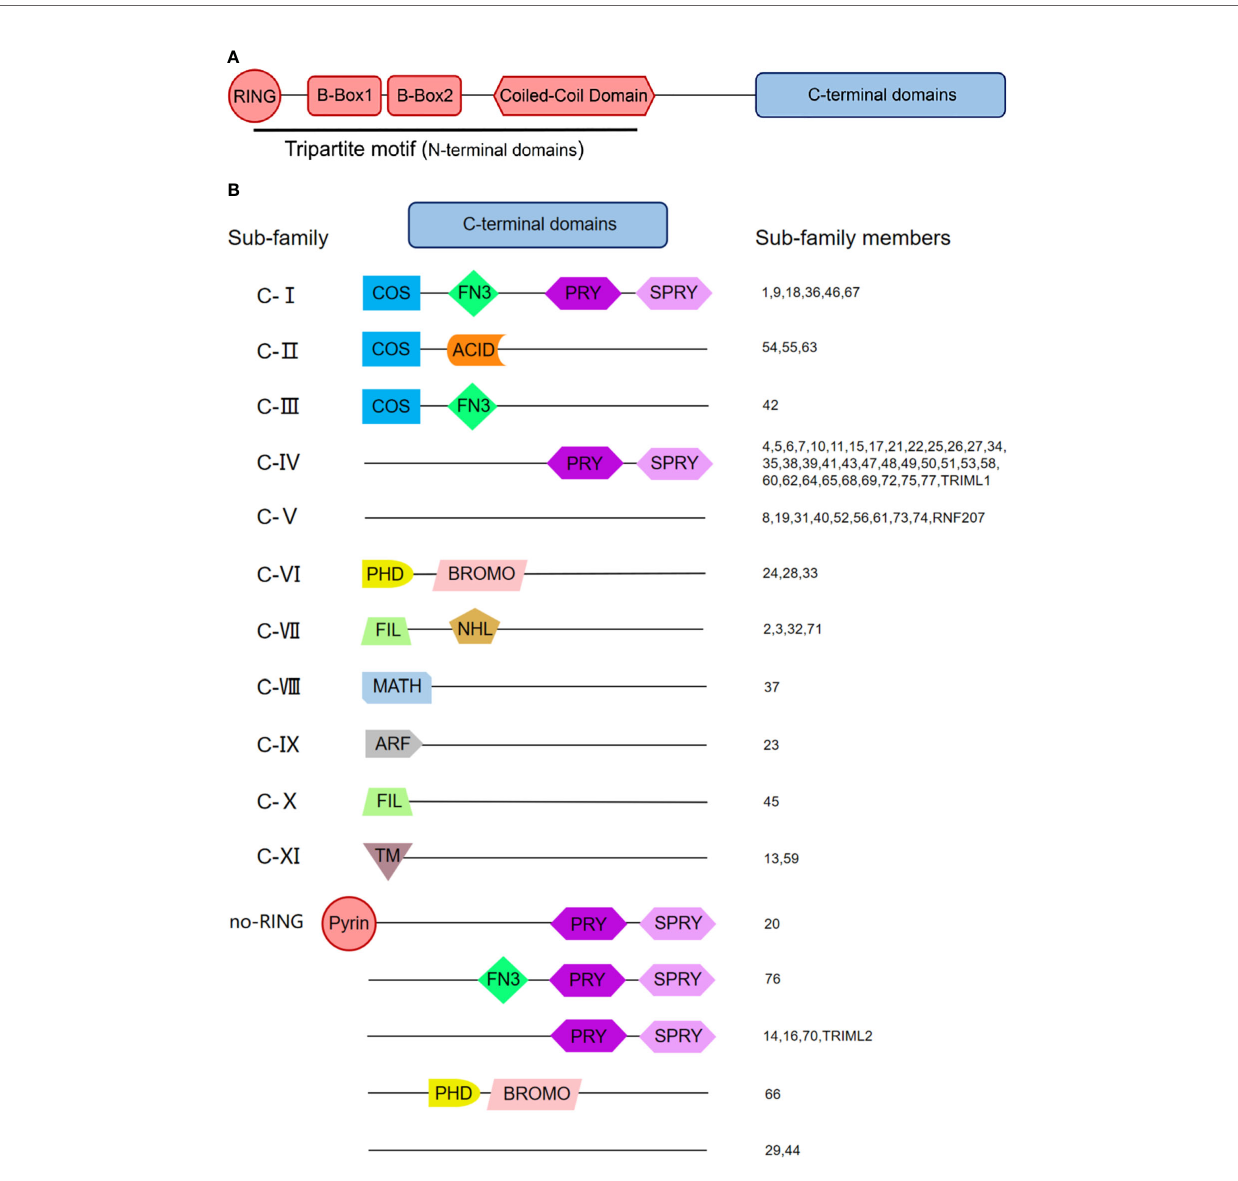
FIGURE 2 | The Domain Structure and the Classi fi cation of Tripartite Motif (TRIM) Family Proteins. (A) Domain structure of TRIM proteins. Most TRIM proteins possess conservative RBCC domains at the amino-terminus and diverse domains at the carboxyl-terminus. RBCC domains consist of a RING fi nger domain, a B- box 1 and/or B-box 2 domain, and a coiled-coil domain (CCD). (B) Classi fi cation of TRIM proteins. TRIM proteins with the RING domain are classi fi ed into 11 subfamilies from Class I to Class XI according to their distinctive C-terminal domains. Besides, there is an unclassi fi ed group lacking the RING domain (no RING). PRY, SPRY-associated domain; SPRY, SPIa and the ryanodine receptor domain; COS, C-terminal subgroup one signature domain; FN3, fi bronectin type 3 domain; ACID, acid-rich region; PHD, plant homeodomain; BROMO, bromodomain; FIL, fi lamin-type IG domain; NHL, NHL repeats; MATH, meprin, and tumor necrosis factor receptor-associated factor (TRAF) homology domain; ARF, ADP-ribosylation factor family domain; TM, transmembrane region. Numbers indicate individual TRIM